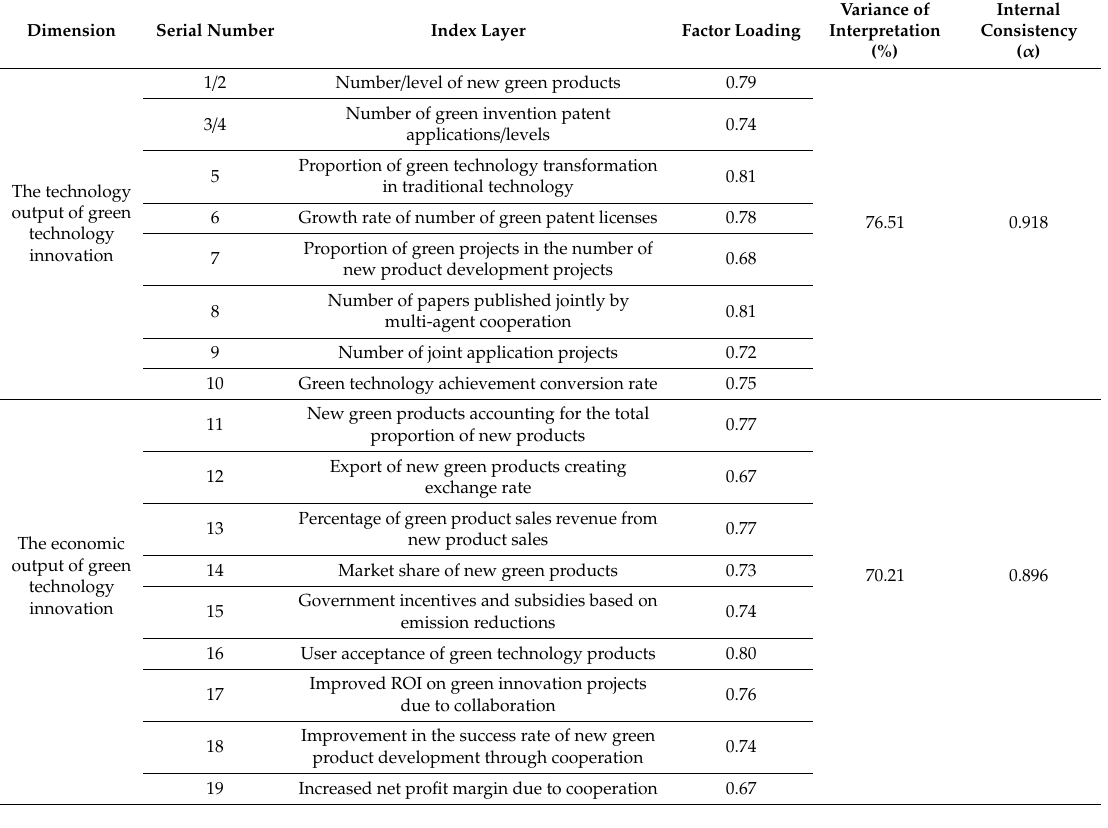
Table 5. The formal evaluation index system of the green technology innovation performance of manufacturing enterprises under multi-agent